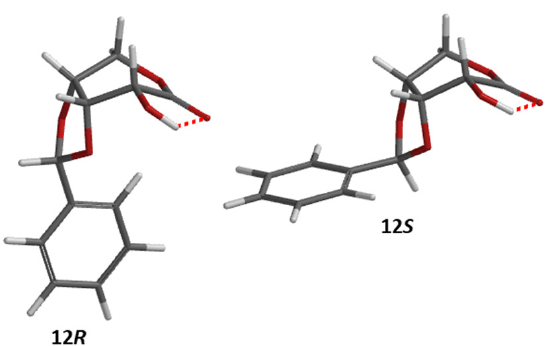
Figure 2. Lower energy conformer calculated in DMSO at 298 K, of 12 R (>99% of population) and 12 S (>99% of population).